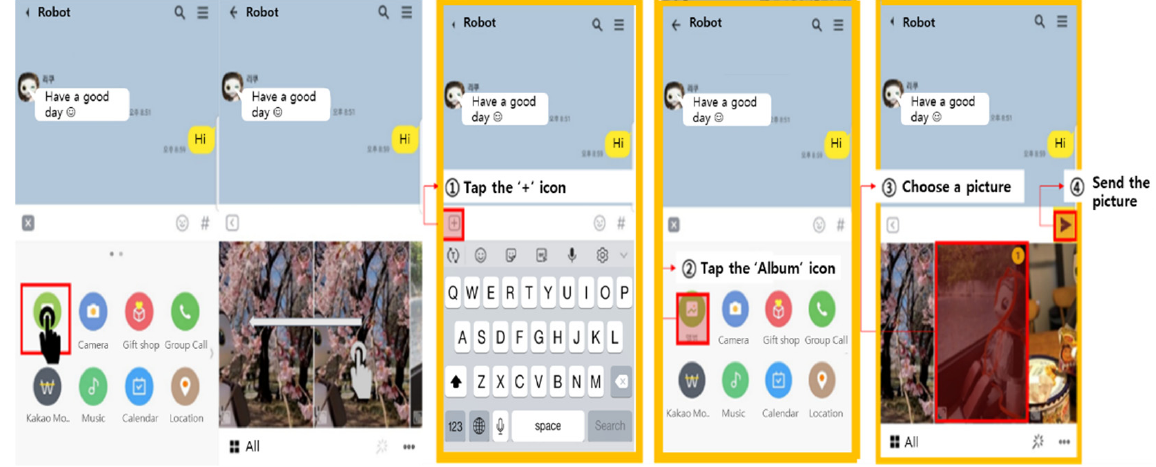
Table 3. Selected functions and sub-functions of the KakaoTalk app.